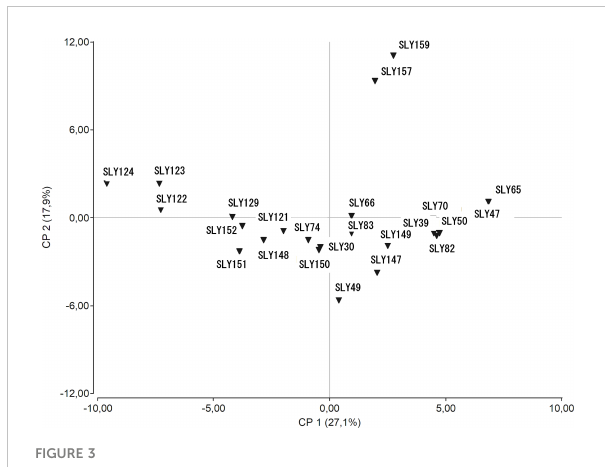
FIGURE 3 Principal components analysis for the tomato accessions panel.